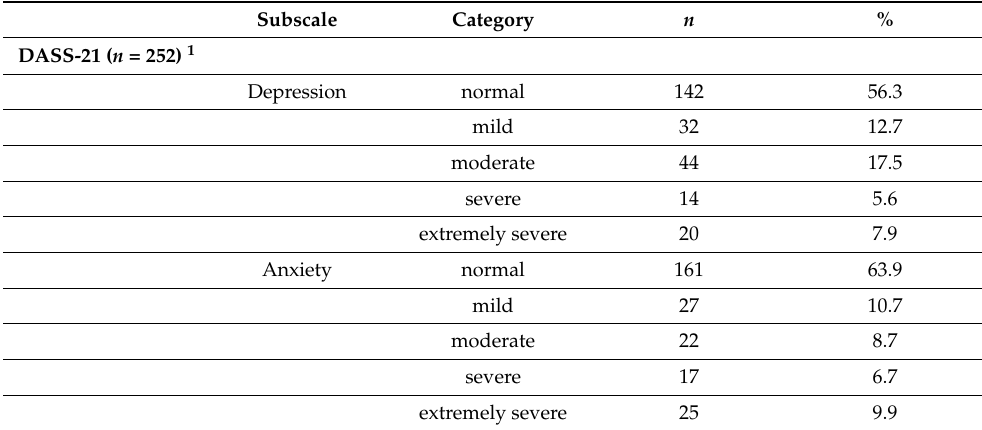
Table 3. Number of dental nurses and total population percentage for each DASS-21 and IES-R subscale